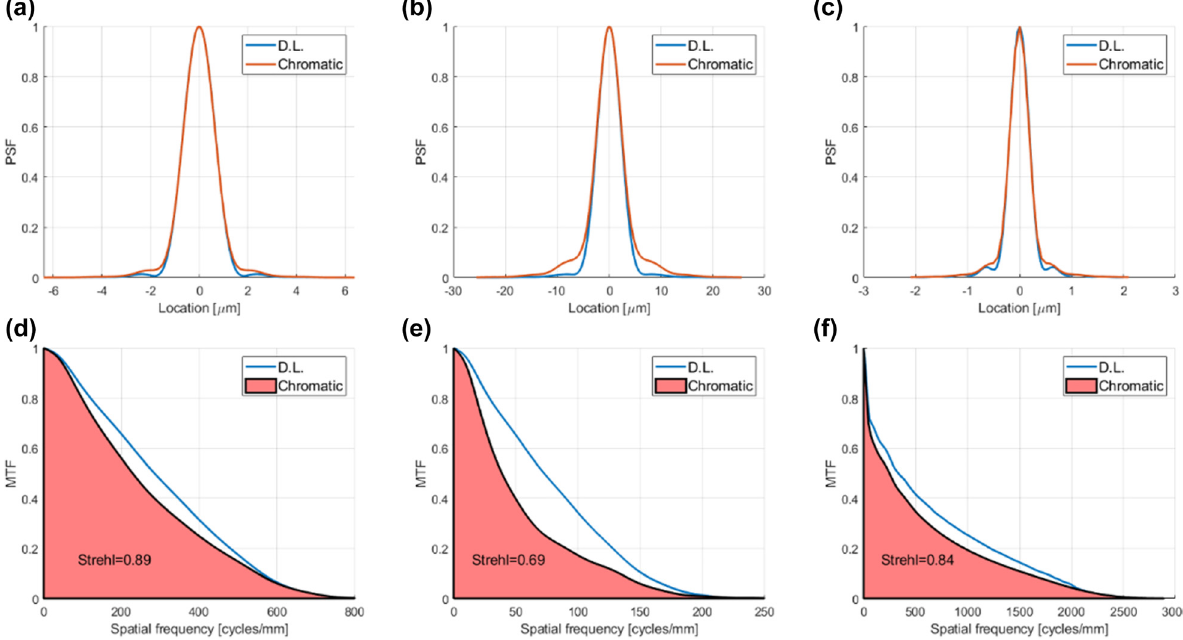
Figure 4: PSFs, MTFs, and 1D Strehl ratio of conventional diffractive lens designs equivalent to broadband achromatic metalens and achromatic diffractive lens designs of [44], compared to the diffraction limit. (a) PSF cross section of conventional diffractive lens equivalent to Design 1 of [44] (b) The same for Design 2 (c) The same for Design 3 (d) MTF of conventional diffractive lens equivalent to Design 1 of [44] (e) The same for Design 2 (f) The same for Design